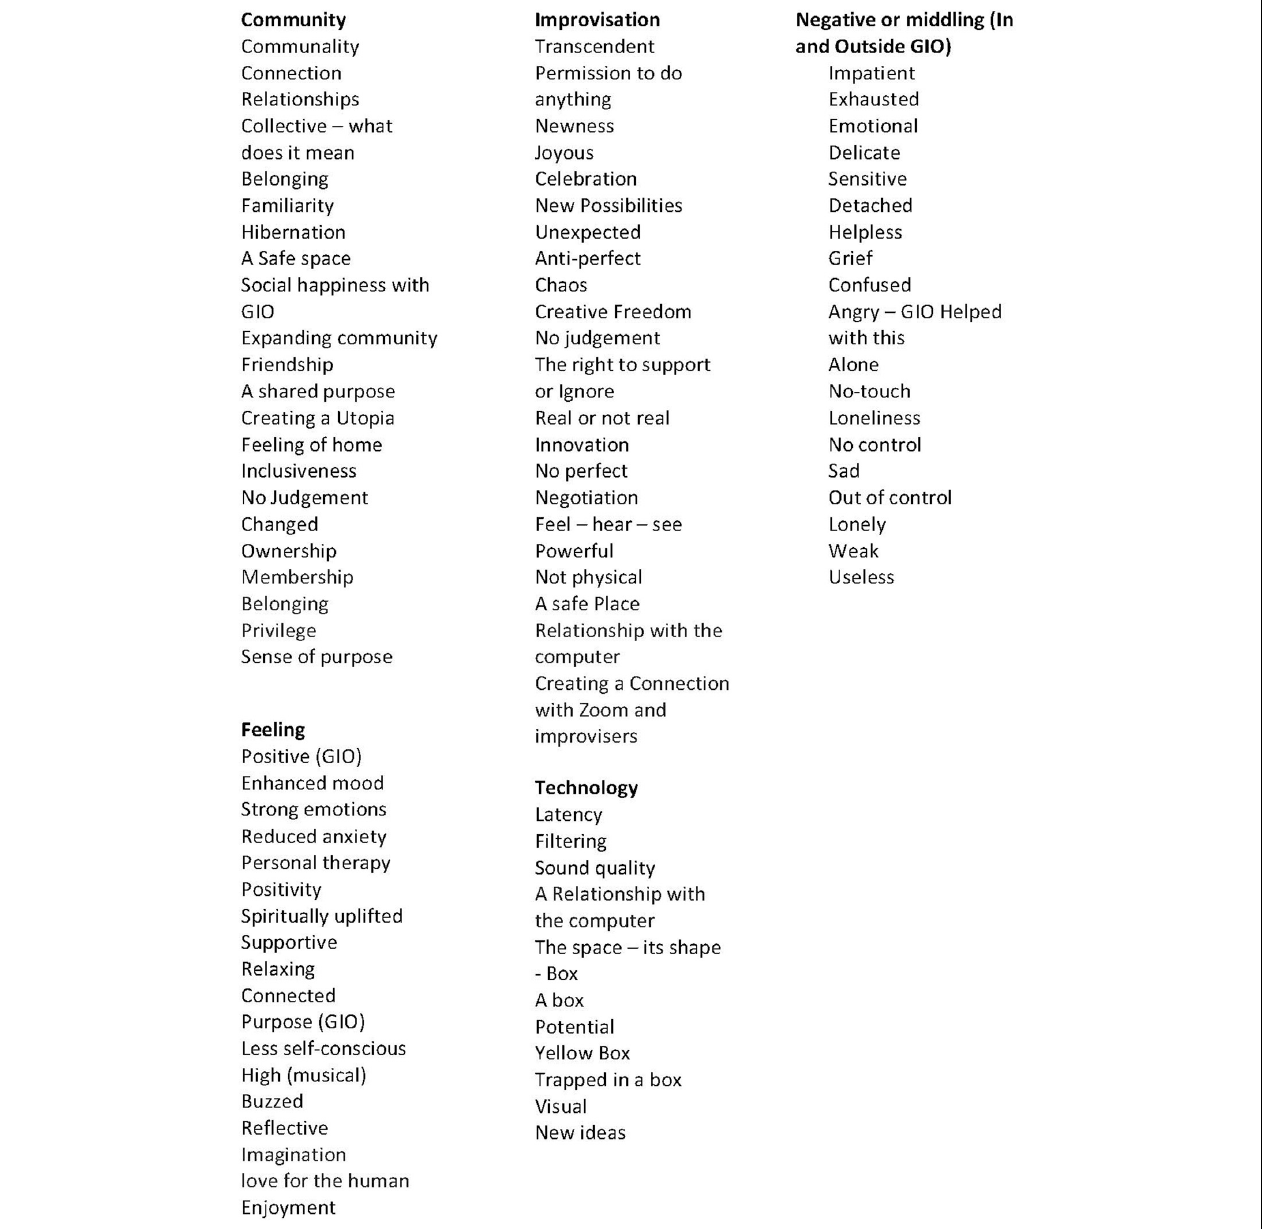
FIGURE 1 | Emergent